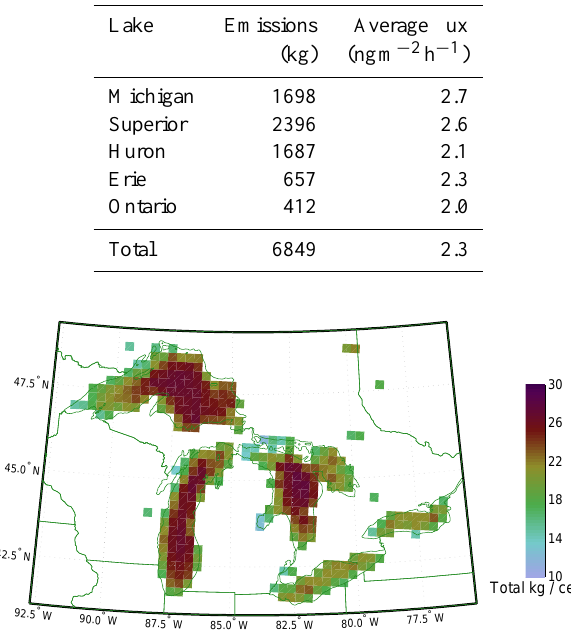
Table 2. Total emissions of GEM from forest fires for the 318 days of the measurements for the domains shown in Fig. 3.